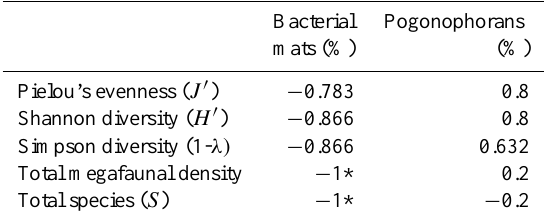
Table 5. Spearman’s rank correlations between taxa richness, total megafaunal densities and diversity indices with coverage of bacte- rial mats or pogonophorans. * p < 0 . 05.